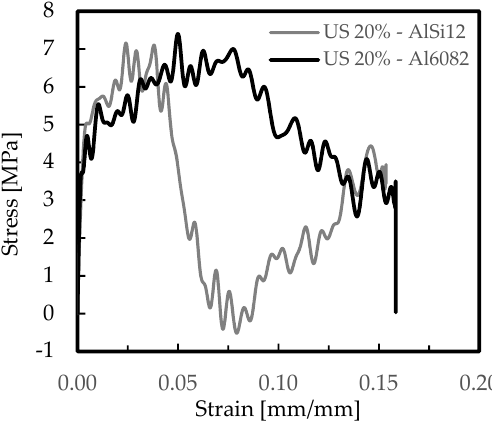
Figure 4. Stress-strain curves for the Al6082-T4 and AlSi12 foams for US 20%. Table 4. Results for the AlSi12 and Al6082-T4 foams US and DS with a relative density of